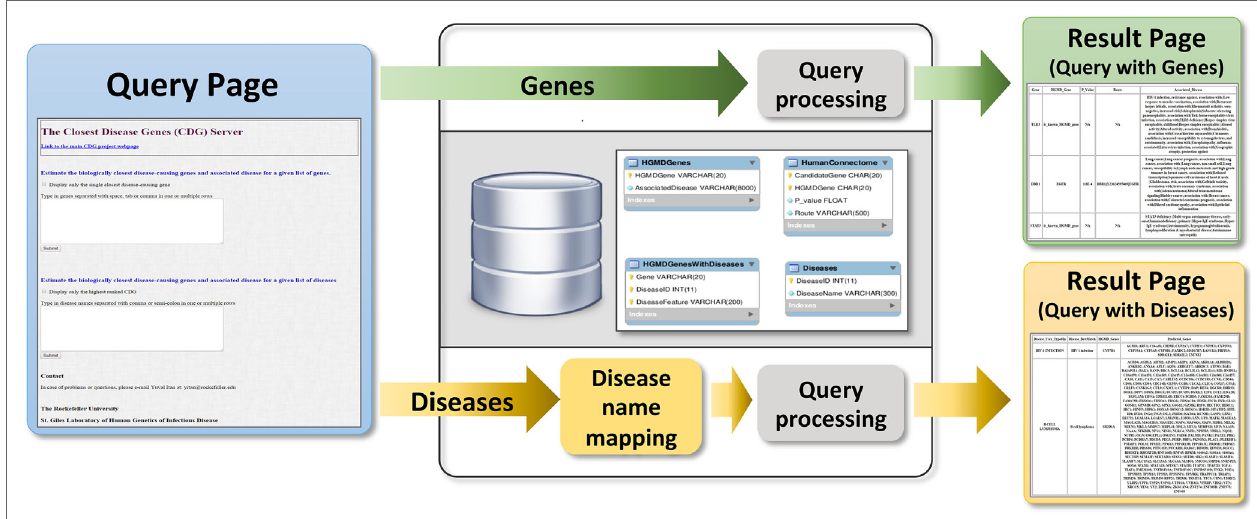
FIGURe 4 | Schematic of the closest disease-causing genes (CDG) server pipeline, where CDG can be estimated by queries of gene or disease lists provided by the